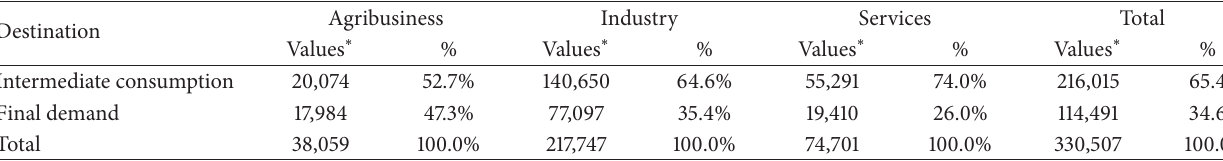
Figure 2: Share of agribusiness aggregates in indirect taxes. Table 6: Destination of Brazilian imports, 2011.